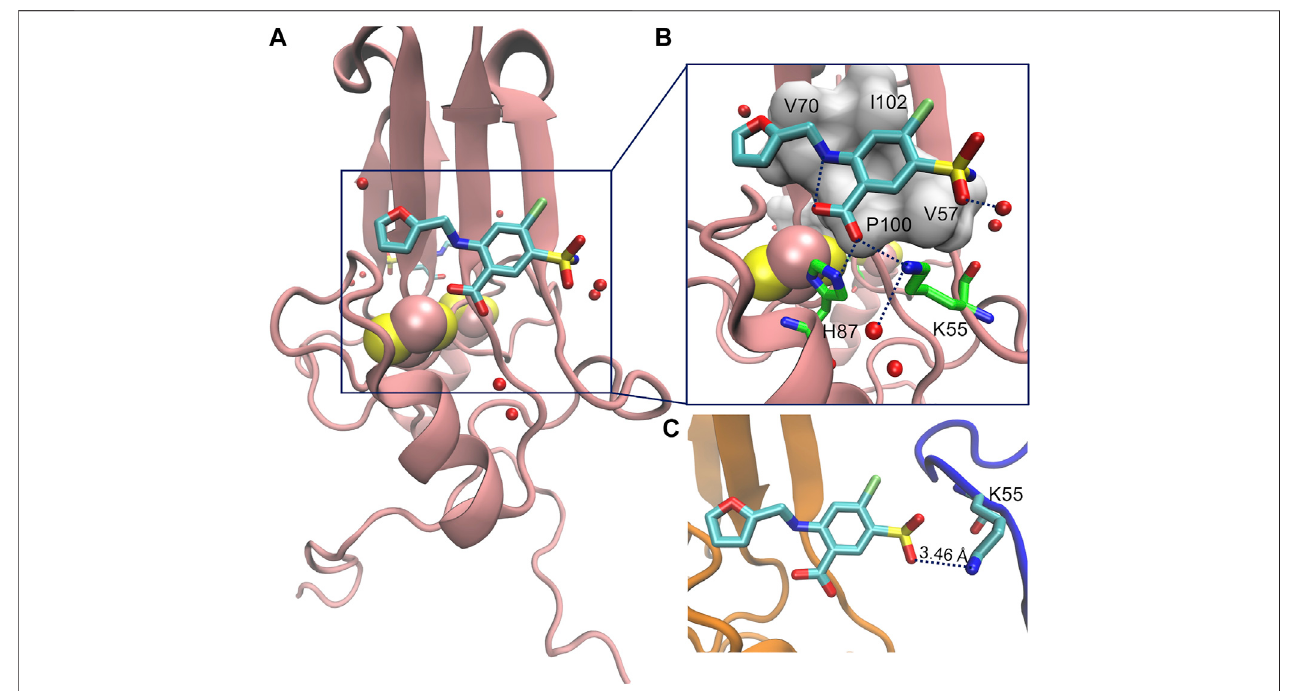
FIGURE 2 | (A) Crystal structure of ligand furosemide binding to mitoNEET protein at pH 7.0. (B) Close up showing furosemide-protein H-bonds/salt bridges interactions. (C) Interactions of the ligand with the protein image (in blue color) in the crystal.